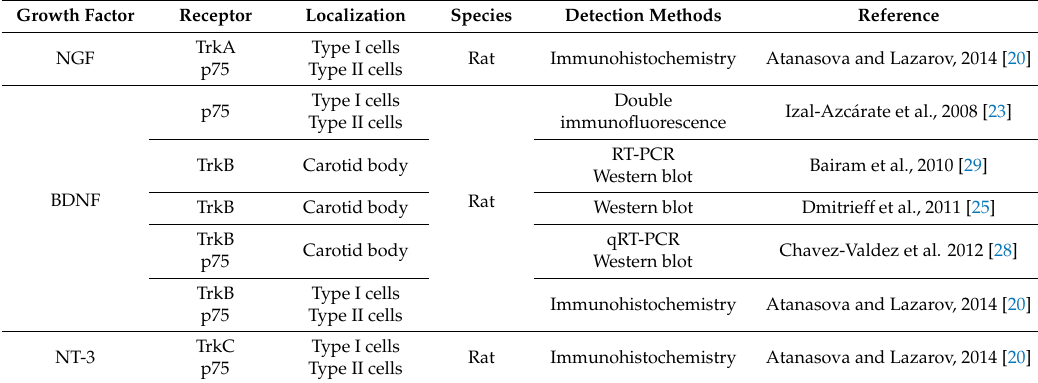
Table 2. Nerve growth factor family receptors. Expression of TrkA, TrkB, TrkC, and p75 in the carotid